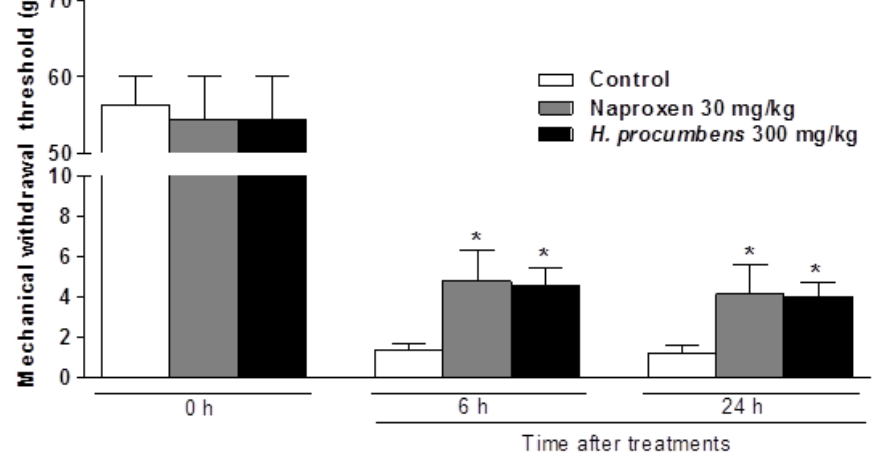
Figure 1. Effect of H. procumbens extracts on mechanical hyperalgesia induced by plantar incision in rats. Baseline assessment of animals, before surgery (day 0), showed no significant variation between groups. 6 h or 24 h after surgery, rats treated with H. procumbens extracts significantly attenuated hyperalgesia in response to von Frey stimulation of injured hind paw. Data are mean ± SEM (n = 6 per group). * p < 0.05, significant difference from the control